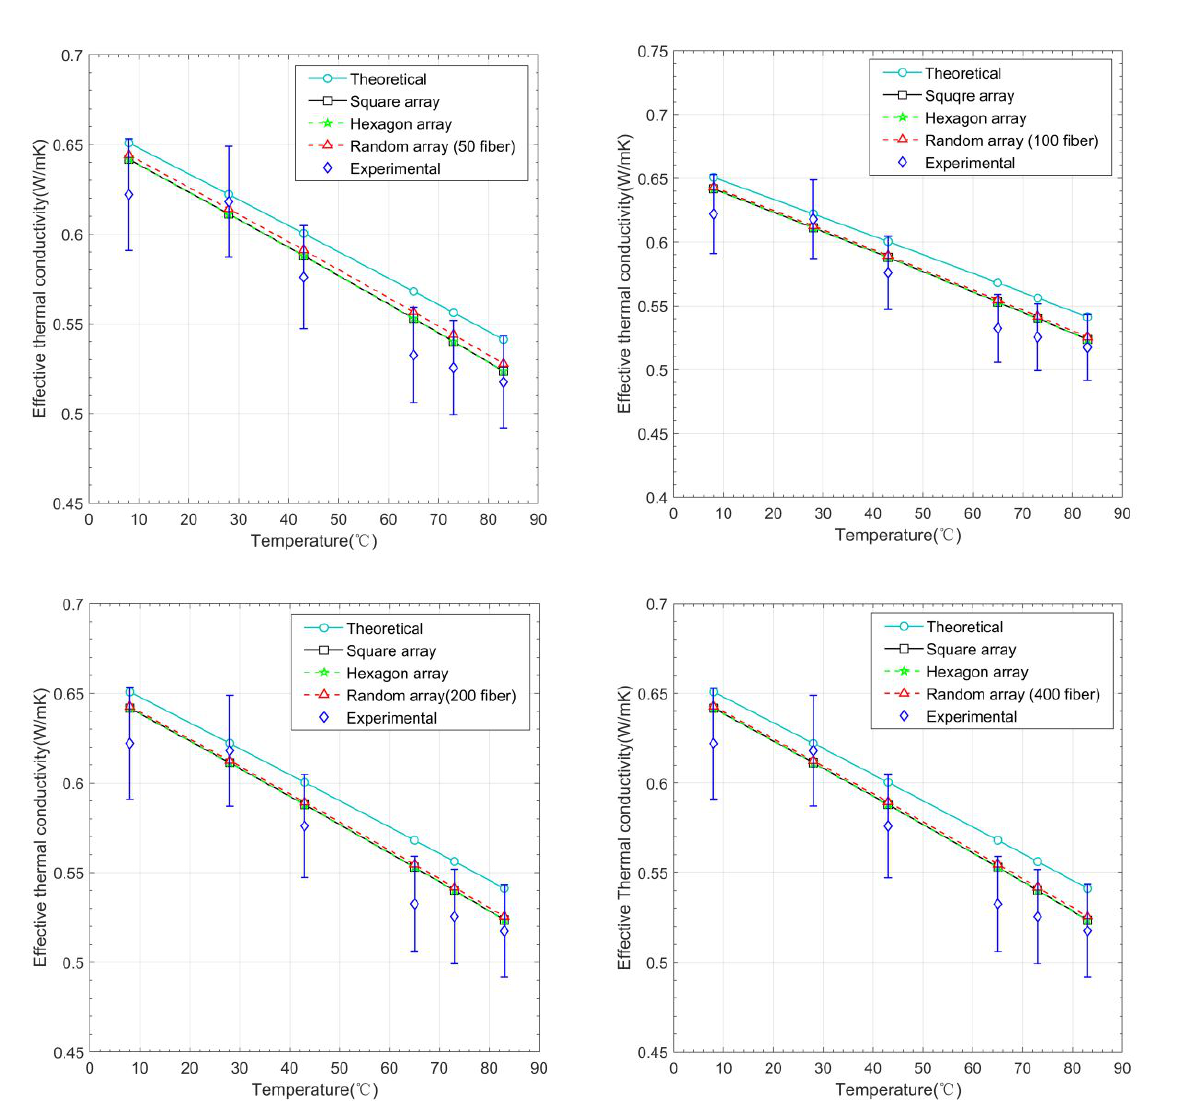
Figure 12: Effective thermal conductivity for different test temperatures with v f = 27%